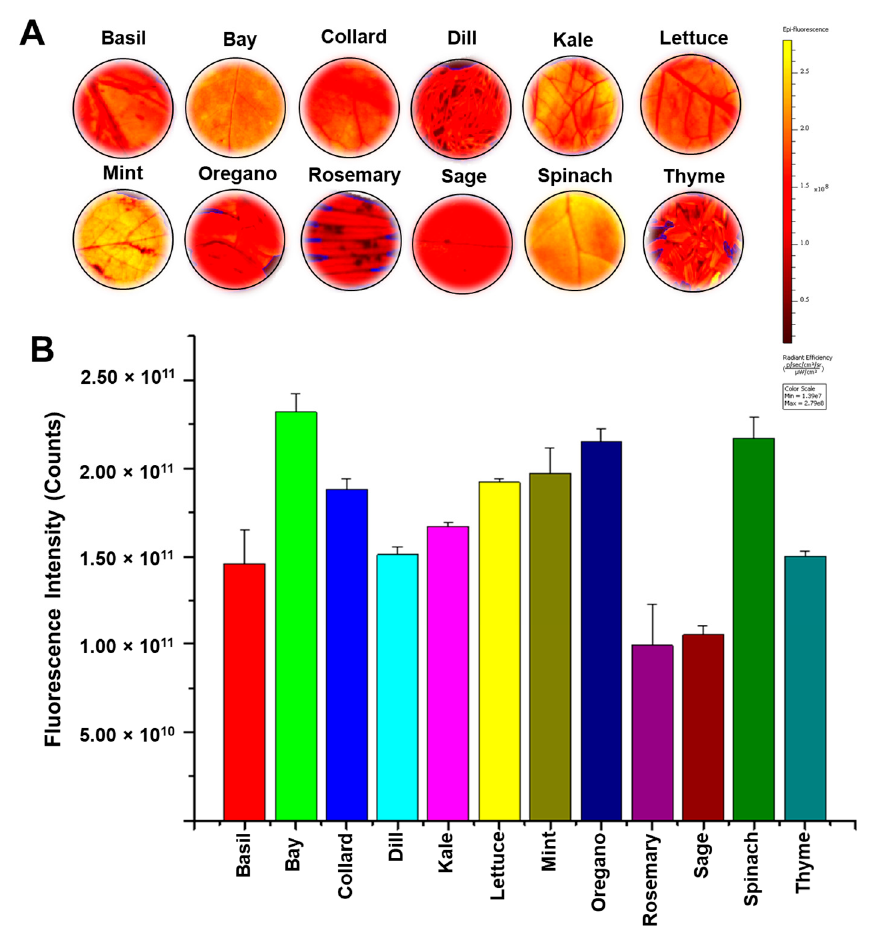
Figure 1. Chlorophyll measurement with IVIS Imaging System. ( A ) Twelve different dietary leaves were imaged using the IVIS Imaging System for chlorophyll content. The chlorophyll fluorescence was measured at an excitation and emission of 600/710 nm. Experiment was performed in triplicate. ( B ) Quantitation of the fluorescence measurement. The figure represents the average of three individual experiments. n = 3.